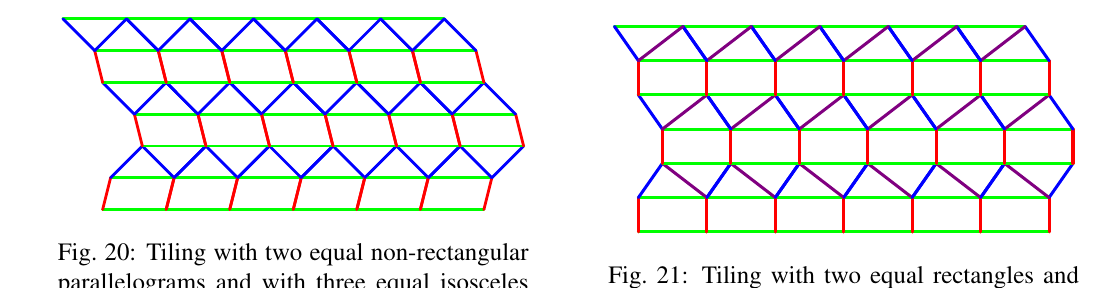
Fig. 21: Tiling with two equal rectangles and three equal non-isosceles triangles